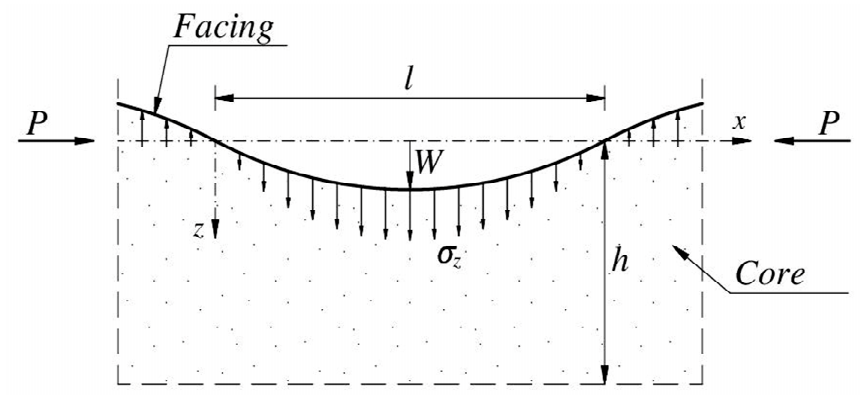
Figure 1. Assumed shape of a wrinkling.